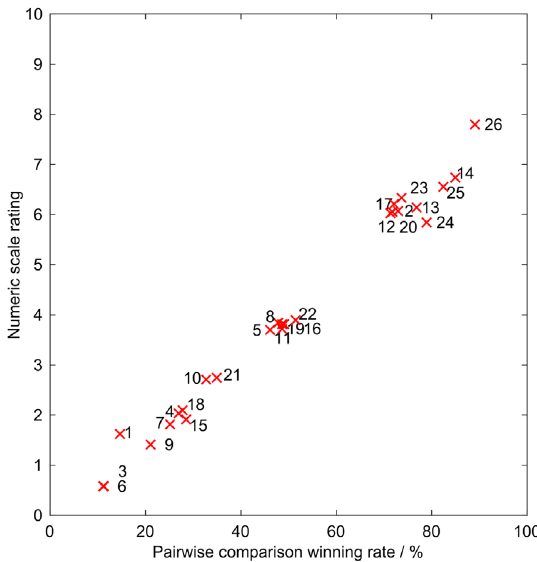
Figure 3. Correlation between average numerical scale rating and the average winning rate WR for each stimulus determined from the results of the pairwise comparison task. The Spear- man ’ s rank correlation coef fi cient between these data was r p < 0.001). The list of stimuli including the de fi nition s = 0.97 ( of the stimuli numbers “ 1 ”–“ 26 ” are summarised in Table